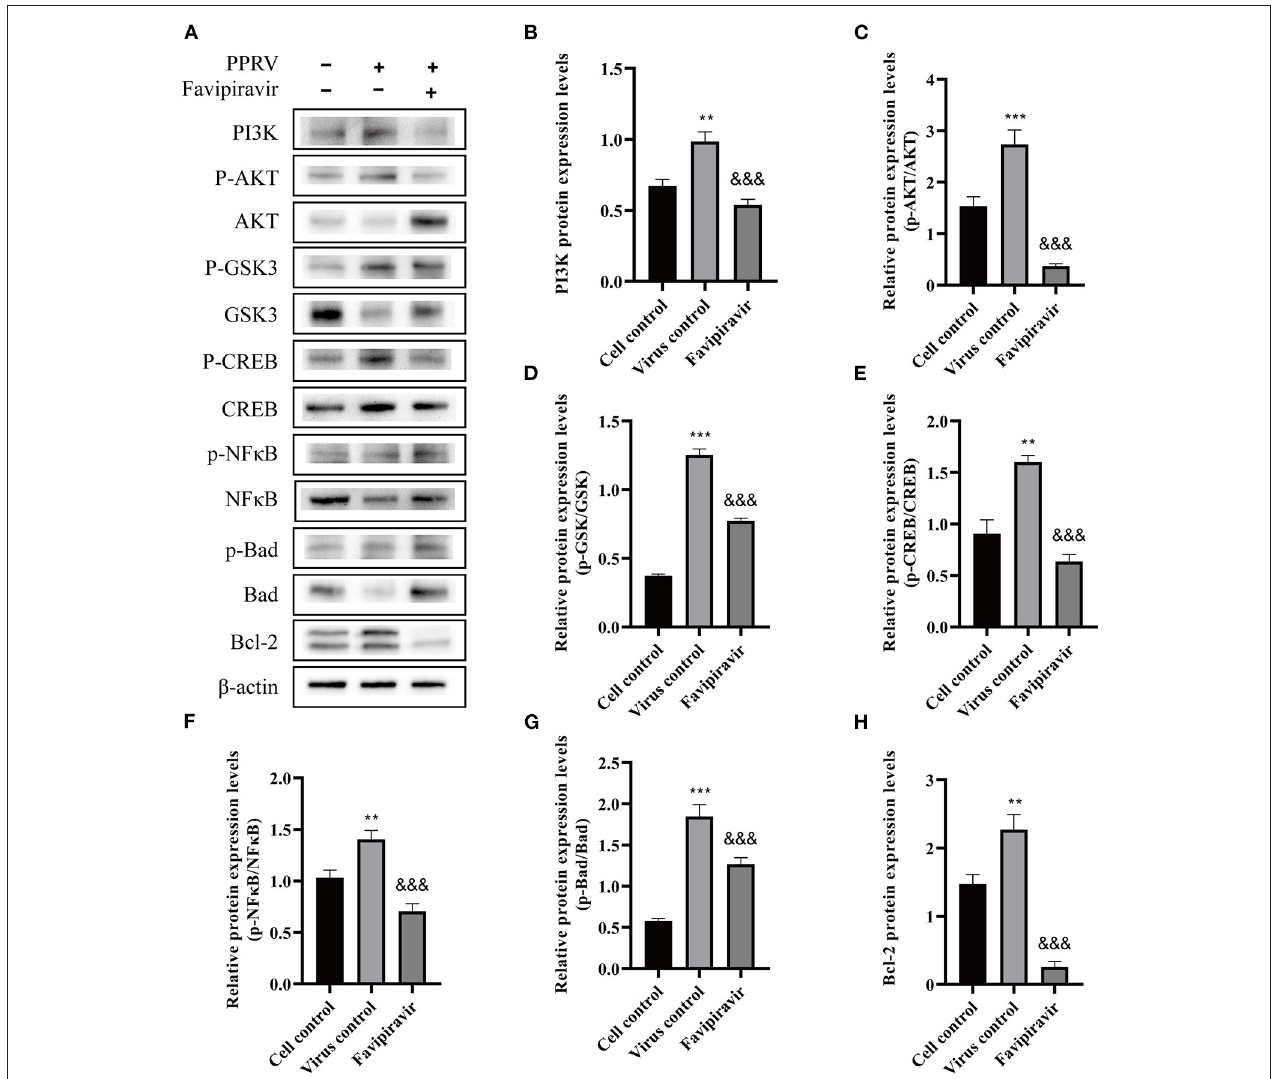
FIGURE 7 | The effects of favipiravir on the expression levels of key proteins related to the PI3K/AKT signaling pathway. Vero cells were simultaneously treated with favipiravir and infected with peste des petits ruminants virus (PPRV); and the expression levels of PI3K, p-AKT, AKT, p-GSK3, GSK3, p-CREB, CREB, p-NF- κ B p65, NF- κ B p65, p-BAD, BAD, and Bcl-2 (A–H) were detected by Western blotting 48h after infection ( &&& p < 0.001 vs. the virus-only control; ** p < 0.01, *** p < 0.001 vs. the cell